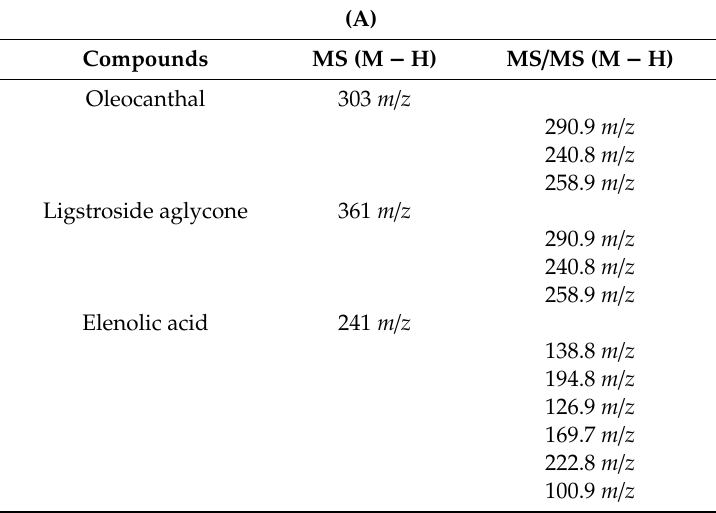
Table 1. Fragmentation profile of identified olive oil polyphenols. ( A ) Reverse phase HPLC–DAD- ESI-MS / MS, ( B ) Percentage